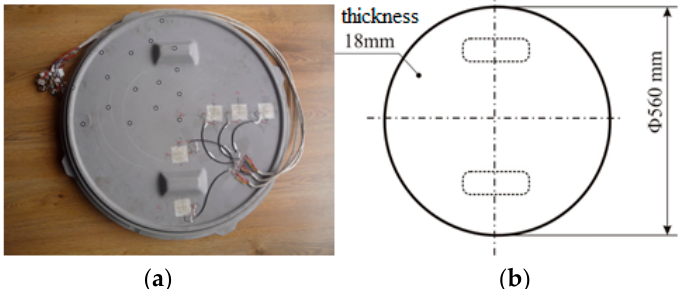
Figure 2. The manhole cover made of sandwich laminated composite material: ( a ) Photo; ( b ) sketch with main dimensions.